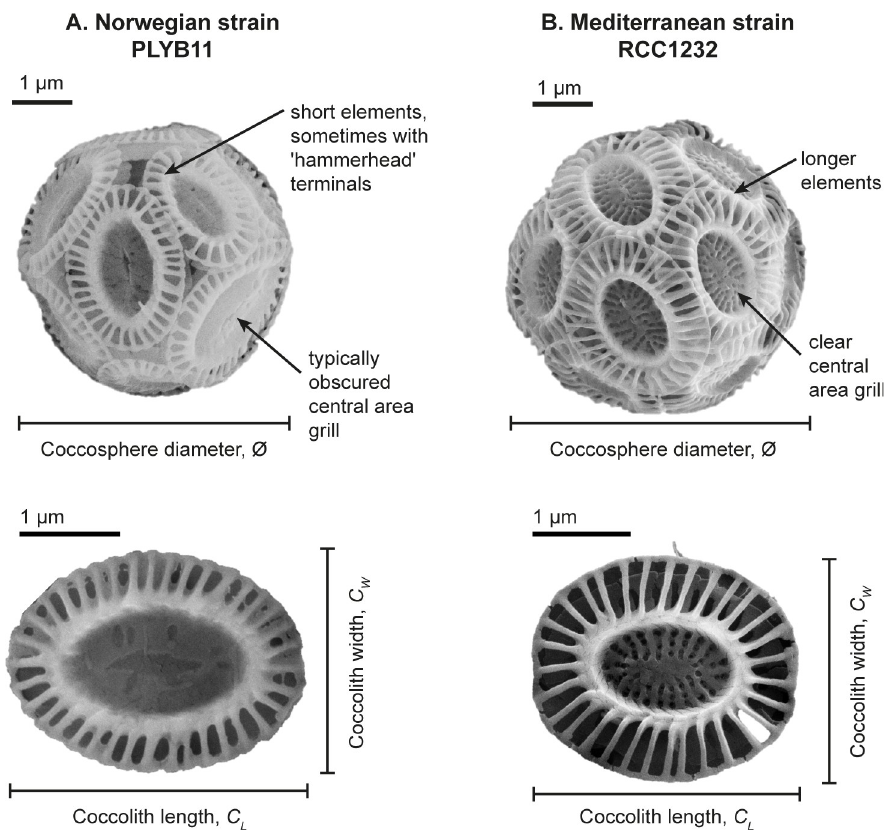
Fig 2. Illustrative coccosphere (top) and coccolith (bottom) of E . huxleyi . (A) strain PLYB11 and (B) strain RCC1232. Distinctive morphological features of each strain are highlighted and measurements of coccosphere diameter ( Ø ), coccolith length ( C L ) and coccolith width ( C W ) referred to in this study are defined. The scale bar represents 1 μ m in all instances. All images are from salinity 35